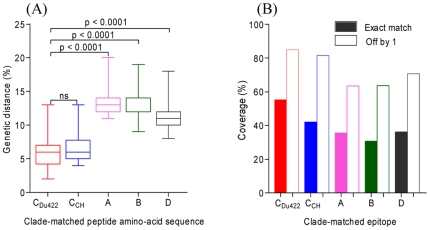
The relationship between infecting viral sequences and peptide amino-acid sequences.(A) Amino acid distances between infecting viral sequences and ELISpot peptide reagent sequences. The median amino acid distance for each peptide set is represented by a solid line. Differences were tested for significance by one way ANOVA test and Dunn's test. (B) Predicted 9mer epitope coverage of two current candidate vaccine peptide sequences (CDu422 and CCH) and consensus clades A, B, and D peptide sequences. For each peptide set, the values shown in a solid bar are exact matches while the open bars show coverage when mismatched by 1 amino acid. Analysis was performed using the p17p24p2 Gag peptides from 39 participants.